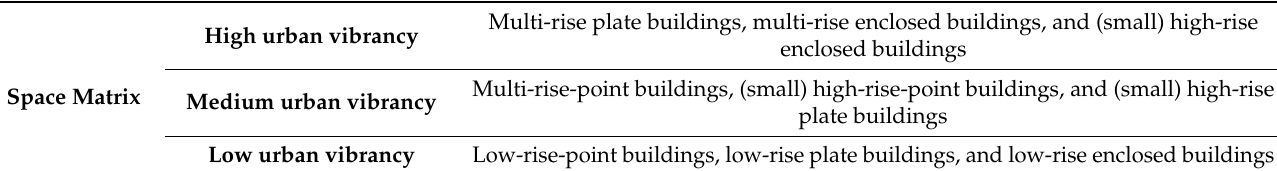
Figure 8. The visualization results of average block size in successful coastal cases. Table 2. The urban vibrancy levels of different building types